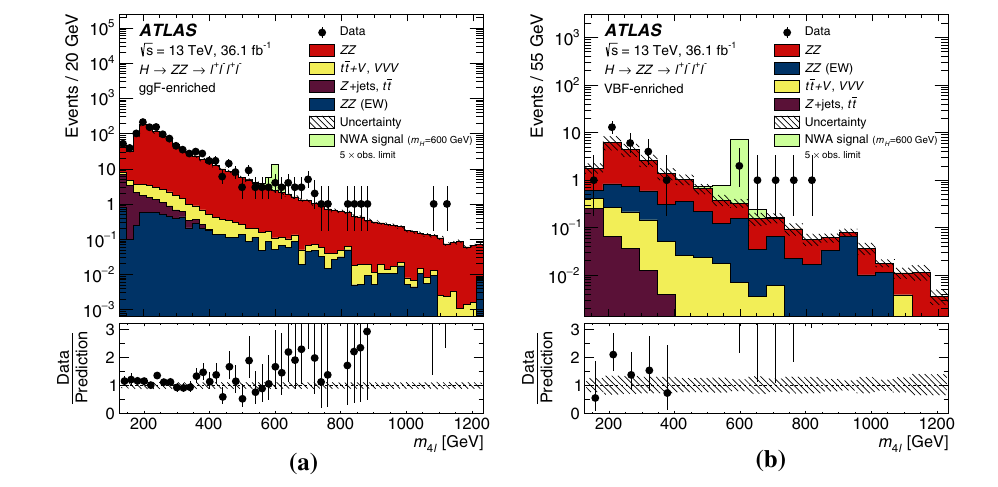
Fig. 4 Distribution of the four-lepton invariant mass m 4 (cid:3) in the (cid:3) + (cid:3) − (cid:3) + (cid:3) − search for a the ggF-enriched category and b the VBF- enriched category. The backgrounds are determined following the description in Sect. 5.2 and the last bin includes the overflow. The simulated m H = 600 GeV signal is normalized to a cross section cor-